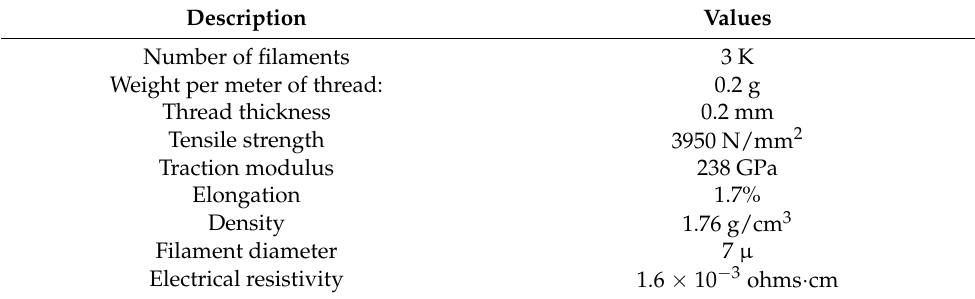
Table 4. General properties of carbon